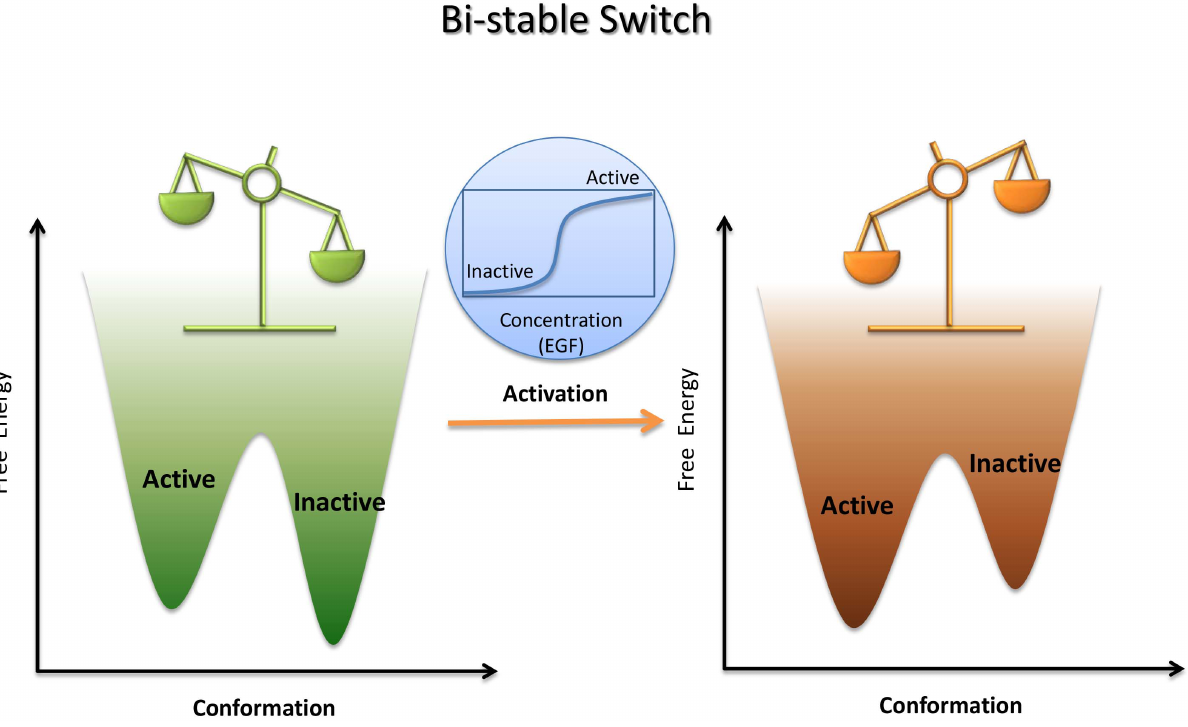
Figure 1. A typical allosteric activation via a bi-stable switch. A node in the cellular network is illustrated by only two populated states, active and inactive, separated by a sizeable but surmountable free energy barrier. Before activation, the inactive state dominates the population as indicated by the relative basin depth in the free energy landscape and a balance level. Within a narrow increment range in ligand concentration, the allosteric activation event shifts the population in favor of the active state. The activation is highlighted in the embedded plot with a typical sigmoid transition from the inactive to the active state.